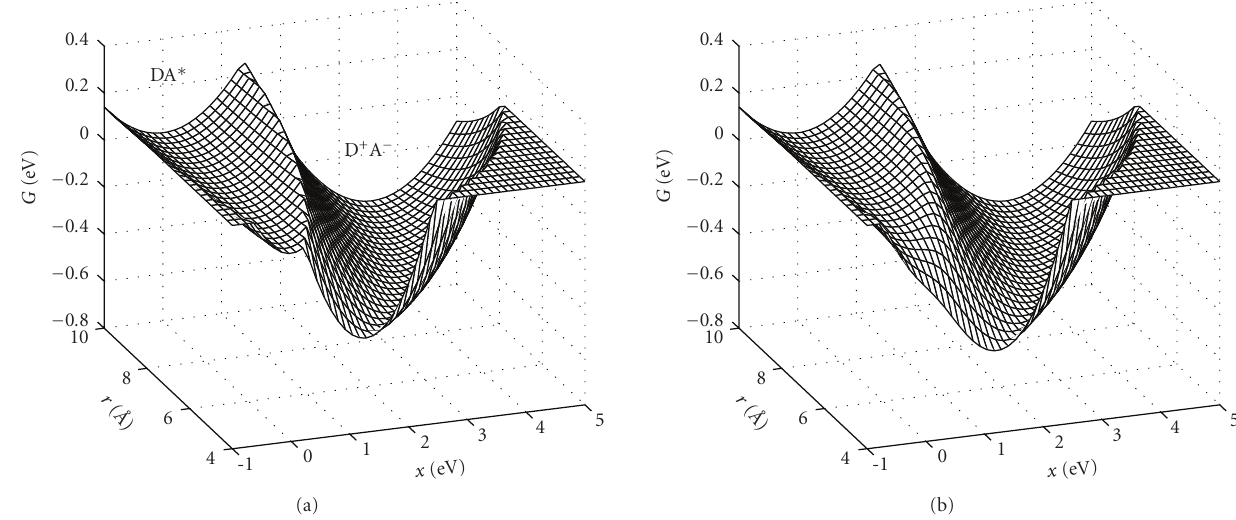
Figure 4: Free energy surfaces of a D-A pair with Δ G AN = − 0 . 4 eV in AN solvent. Only the parts relevant to ET reactions are shown, (a) the mixing of the initial and final states not taken into account; (b) mixing taken into account.